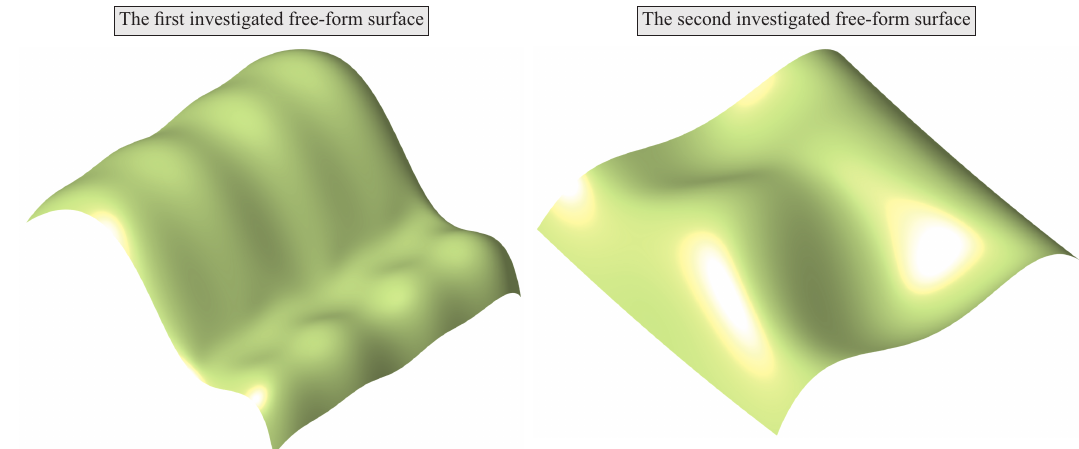
Figure 11. The investigated free-form surfaces of the